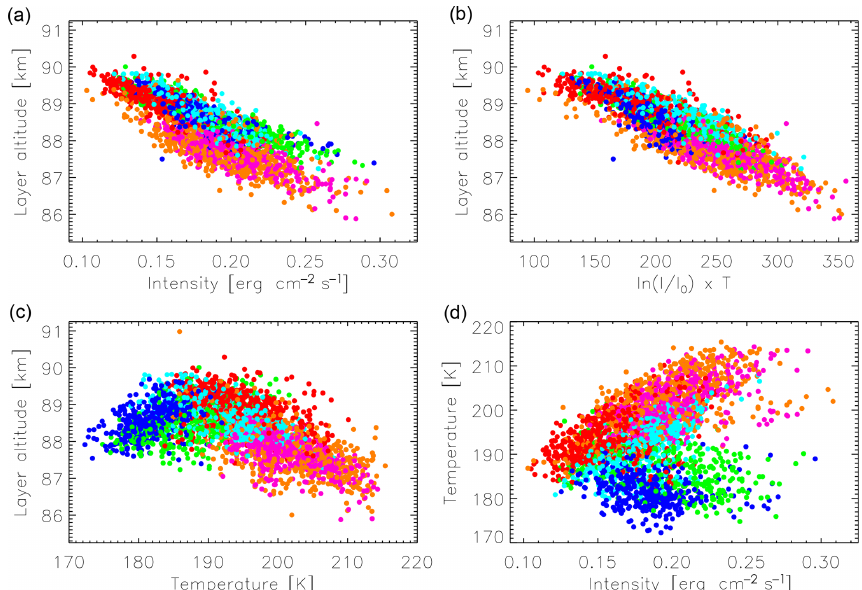
Figure 3. Relationship between SABER OH layer altitude and intensity (a) , T oh × ln I oh (b) and equivalent temperature (c) and between equivalent temperature and intensity (d) . Colors are the months of the year (red: JF, green: MA, dark blue: MJ, light blue: JA, pink: SO, orange: ND).